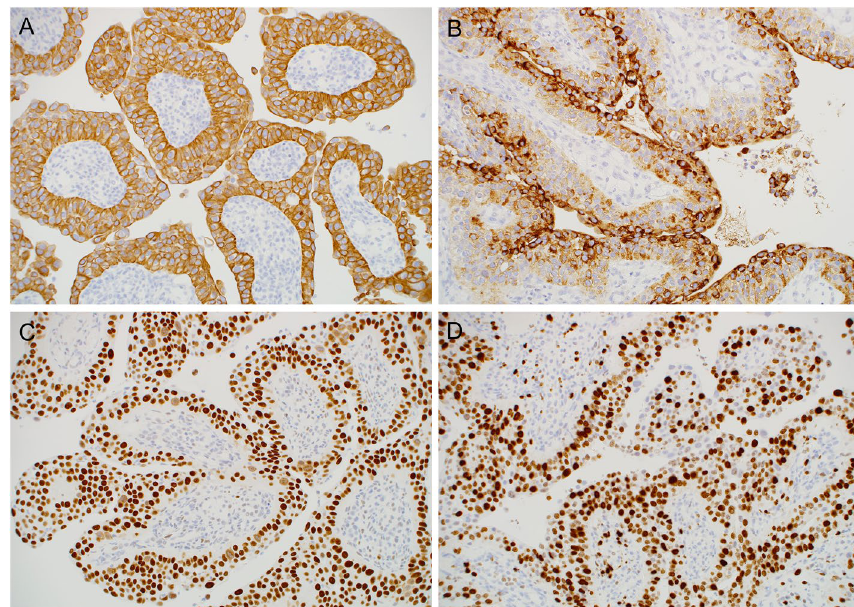
Fig. 3 Immunohistochemical findings. A The tumor was diffusely and strongly positive for CK5/6. B EMA was mainly expressed in the outermost cell layer. C p53 was strongly positive in almost all tumor cell nuclei. D The Ki67 labeling index was about